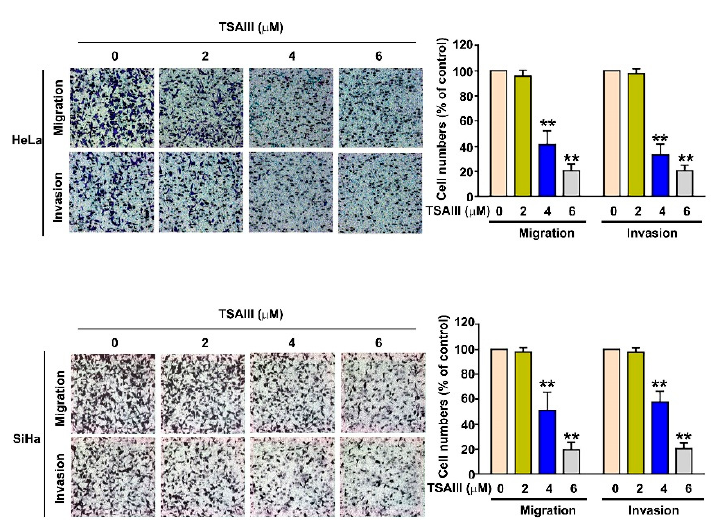
Figure 3. Effect of TSAIII on cell migration and invasion in human cervical cancer cells. Human HeLa and SiHa cervical cancer cells were exposed to various concentrations of TSAIII (0, 2, 4 and 6 µM) for 24 h, which was then followed by measuring the capacity of cellular migration for 16 h and invasion for 24 h. ** p < 0.01 versus control (line 1) (mean ± SE, n = 3).